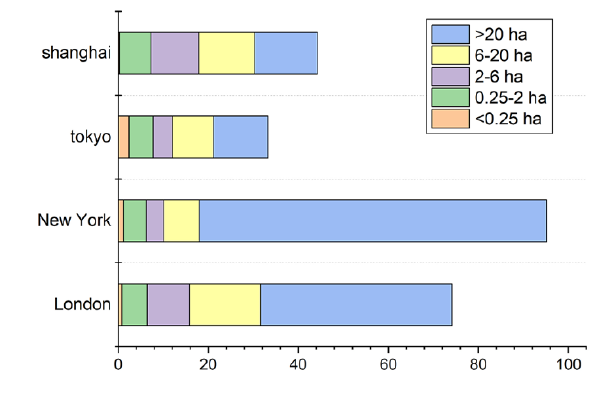
Figure 2. The area of green open space